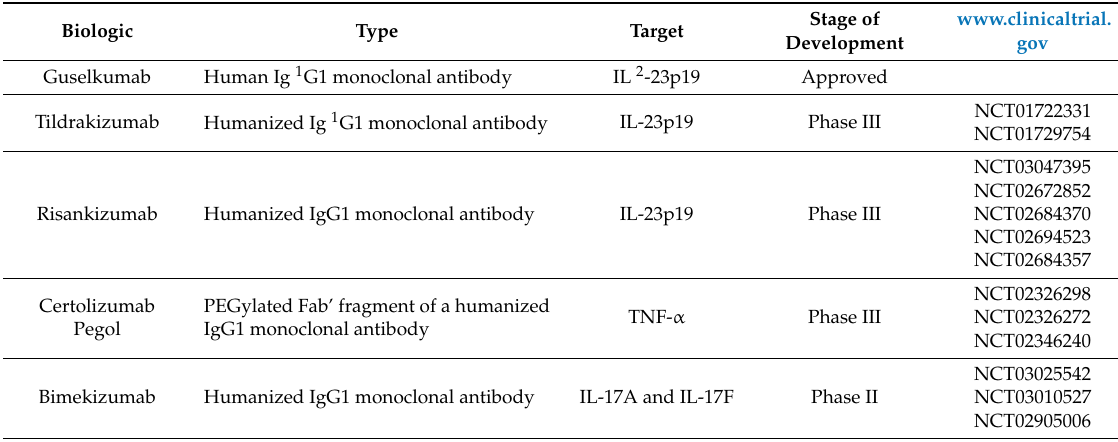
Table 2. Biologics under development for psoriasis as of June 2017. Search at